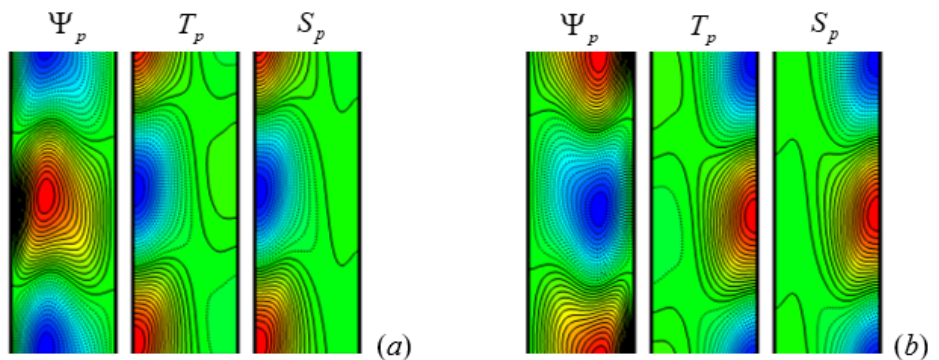
Hopf Ψ p , T , for p , and S p at the threshold of Hopf bifurcation, R , T , and at the threshold of Hopf bifurcation, Figure 5. Perturbation profiles TC p p = 863.44 and A C = 2.91, ( a ) p i = 27.13, and TC